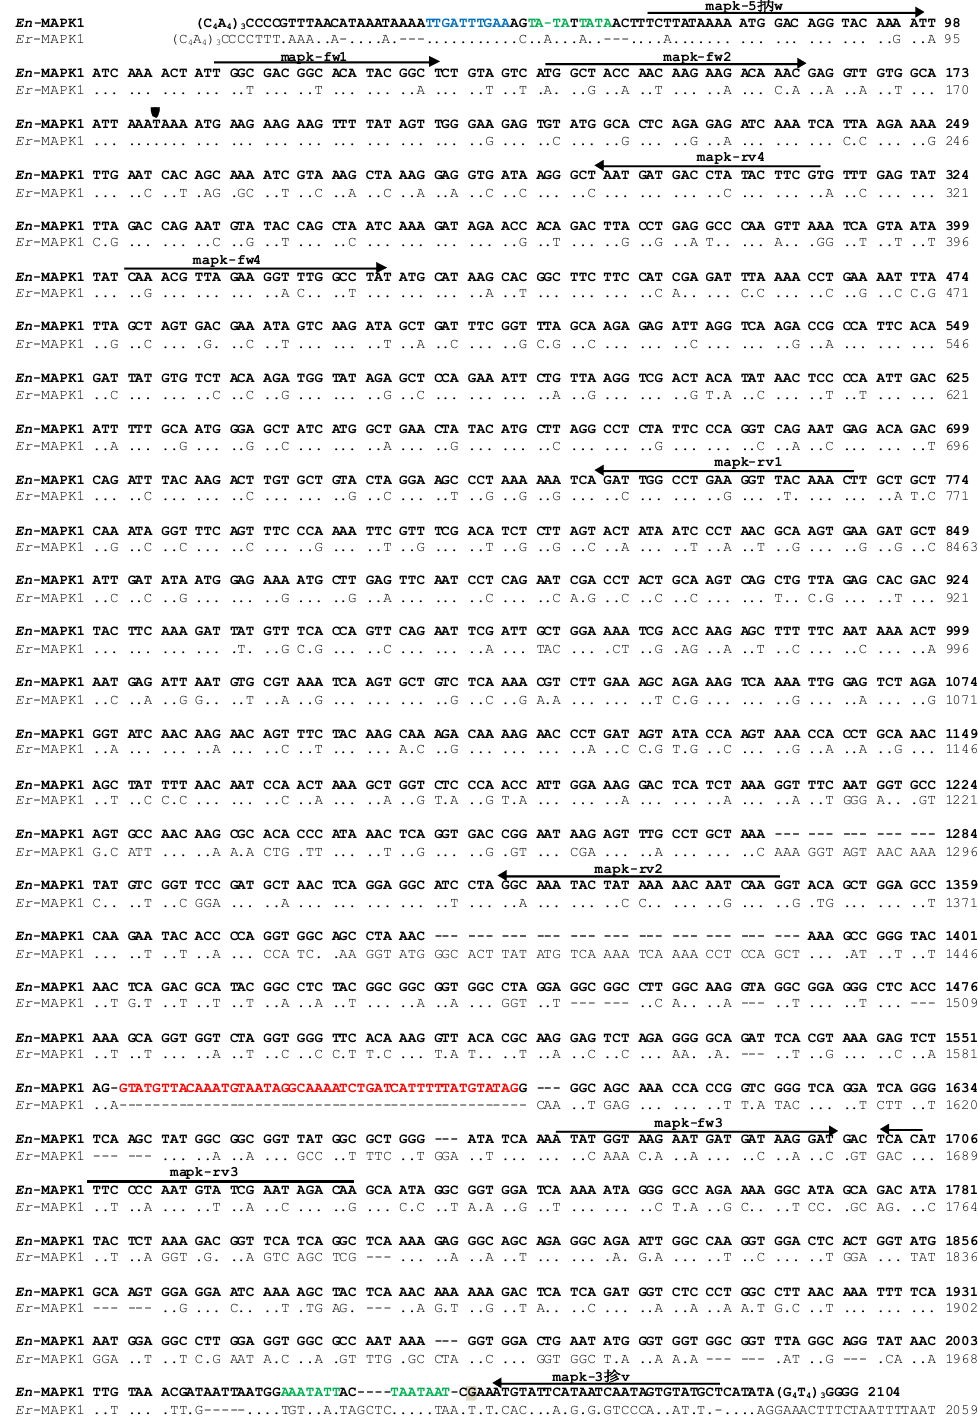
Figure 2. Nucleotide sequence alignment between the En -MAPK1 (in bold) and Er- MAPK1 genes. The alignment was maximized by gap insertions and dots stand for identical nucleotides. The +1 frameshifting site is indicated by an arrowhead, and the intron sequence is highlighted in red. Putative chromosome fragmentation site is in blue, while elements for the transcriptional control and polyadenylation signals are in green. The nucleotide of transcription termination is highlighted in gray. Arrows indicate positions, directions, and denominations of the PCR primers. Numbers on the right indicate the nucleotide positions. mapk-5 抐 w En-